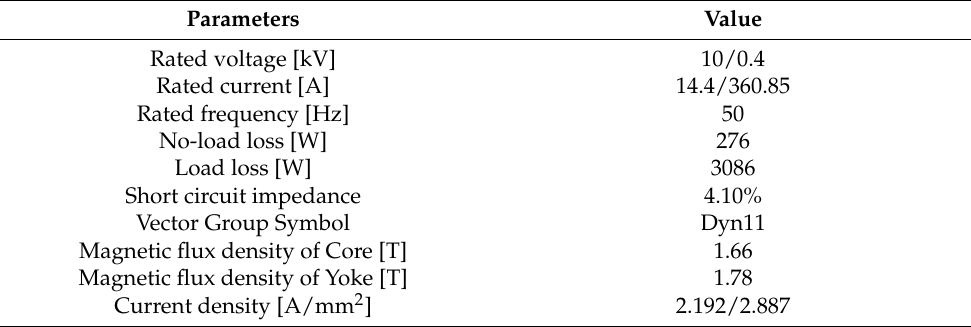
Table 2. Parameters of transformer.